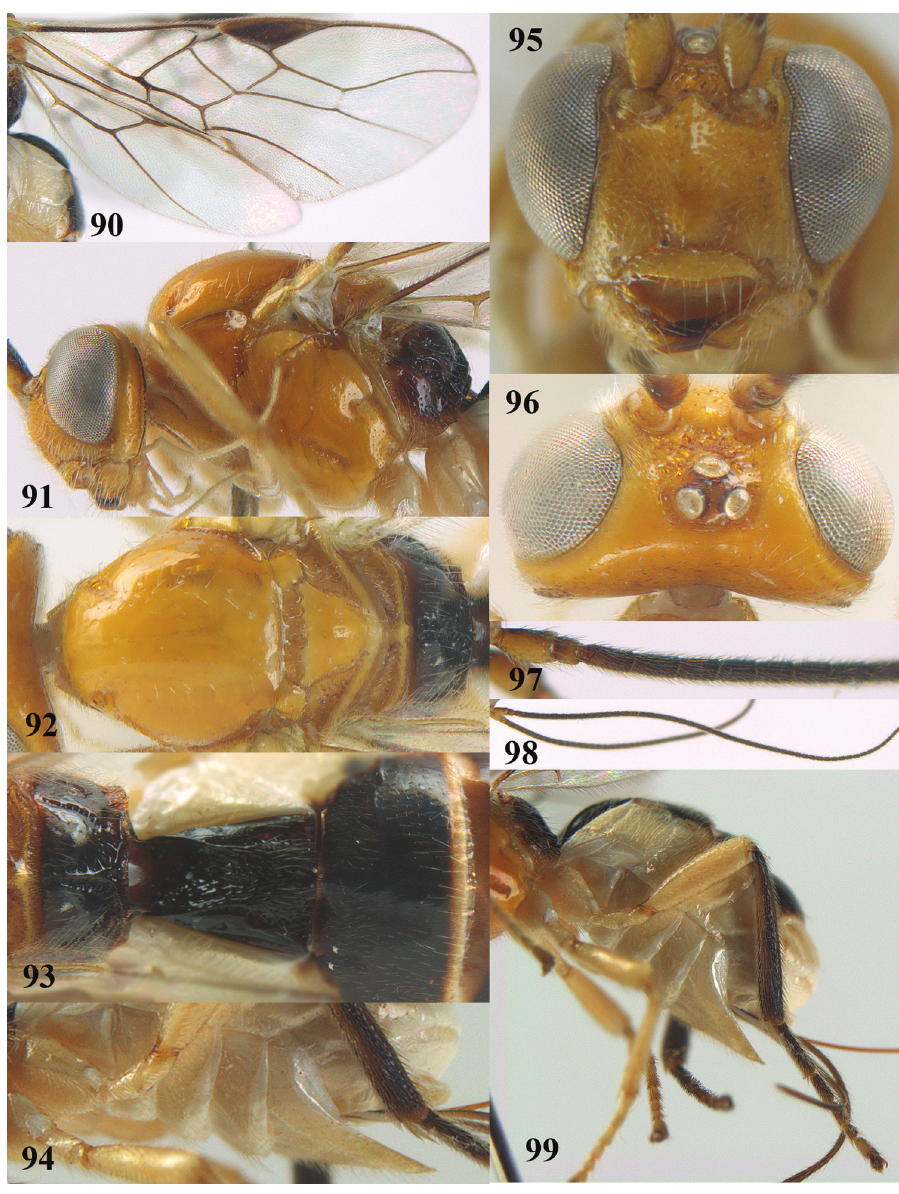
Figures 90–99. Psyttalia spectabilis sp. n., ♀ , holotype. 90 wings 91 head and mesosoma lateral 92 mes- osoma dorsal 93 propodeum and first–third metasomal tergites dorsal 94 hypopygium lateral 95 head anterior 96 head dorsal 97 base of antenna 98 antenna 99 hind leg and hypopygium lateral. finely crenulate ventrally; mesosternal sulcus deep, narrow and finely crenulate; postpectal carina absent; mesoscutum shiny and glabrous (Fig. 92); notauli only anteriorly as pair of nearly smooth impressions and absent on disc, but notaulic courses indicated by